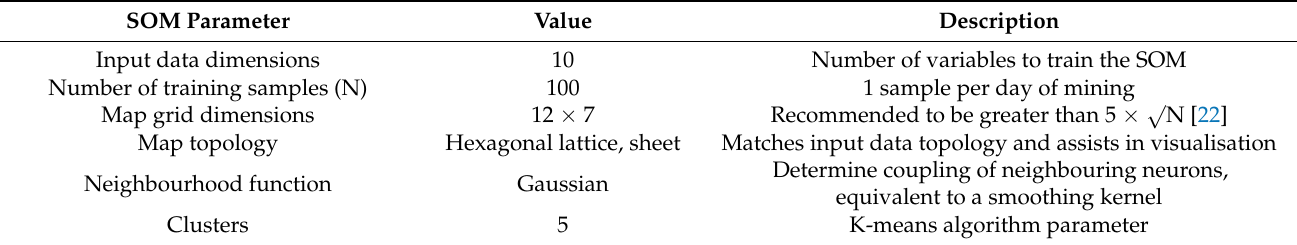
Table 5. SOM parameters used in the data